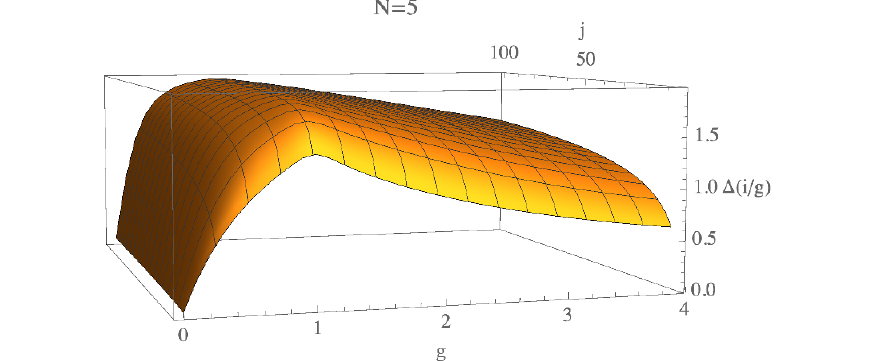
Figure 8. g (cid:0) j plot for the interpolating function (5.9) for N = 5 for (cid:18) = 0 and (cid:28) = i=g . One can notice here, since the supergravity data falls like O ( 1 ) for a (cid:12)xed N , the shape of the curve j 2 almost does not change after some initial values of j . The interpolating function has peak value at g = 1 which corresponds to one of the duality invariant point (cid:28) = (cid:28) S .